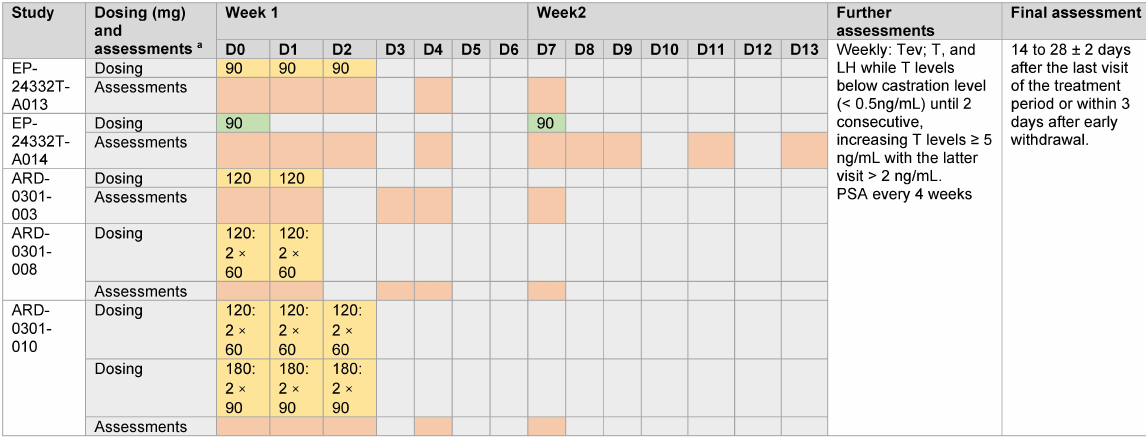
Figure 1. Teverelix DP dose and regimen and evaluation days in the Phase 2 clinical trials. Yellow box = subcutaneous (SC) injection; green box = intramuscular (IM) injection; orange box = assessment days for teverelix, testosterone and luteinizing hormone. D = day; LH = luteinizing hormone; PSA = prostate-specific antigen; Tev = teverelix; T = testosterone. a Tev, T, LH and PSA were measured during screening and at baseline prior to dosing. Teverelix levels were assessed at 1, 2, 4, 6 and 10 and 24 h after dosing and on days specified. PSA was measured at screening, Day 7 and Weeks 2 (ARD-0301-003, ARD-0301-008 and ARD-0301-010 only), 4, 8 and 12 and the final